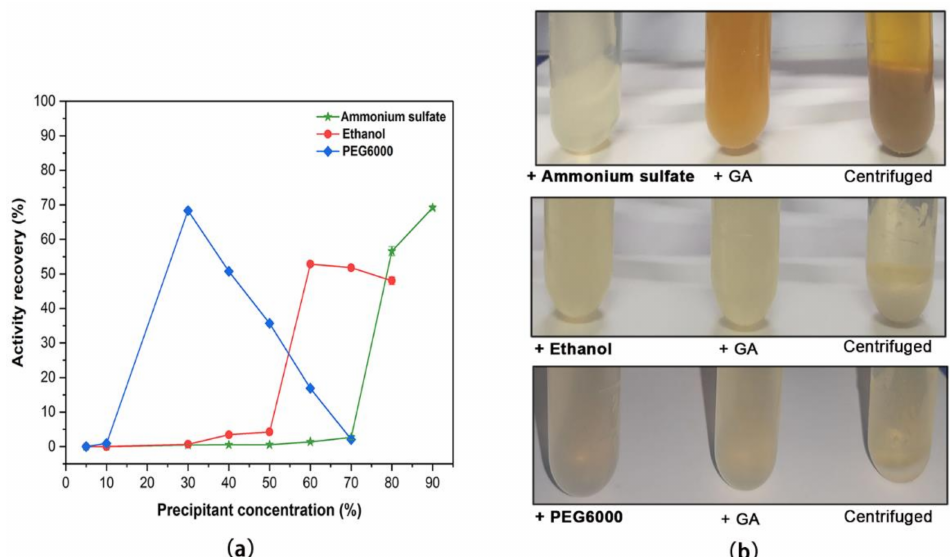
Figure 1. Preparation and structural analysis of α -galactosidase CLEAs. ( a ) The effects of different agents on precipitation of α -galactosidase. The tested precipitants were ammonium sulfate (30–90% saturation at 4 ◦ C), ethanol (5–80%, v/v ), and PEG6000 (5–70%, w/v ), respectively. ( b ) The process of CLEAs formation. The enzyme was precipitated, cross linked, and centrifuged to yield CLEAs that were distributed at the bottom of the tube. Ammonium sulfate, ethanol, and PEG6000 were used at 90%, 60%, and 30%, respectively. GA,